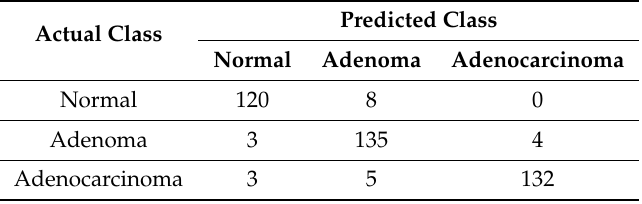
Table 6. Confusion matrix of the experimental